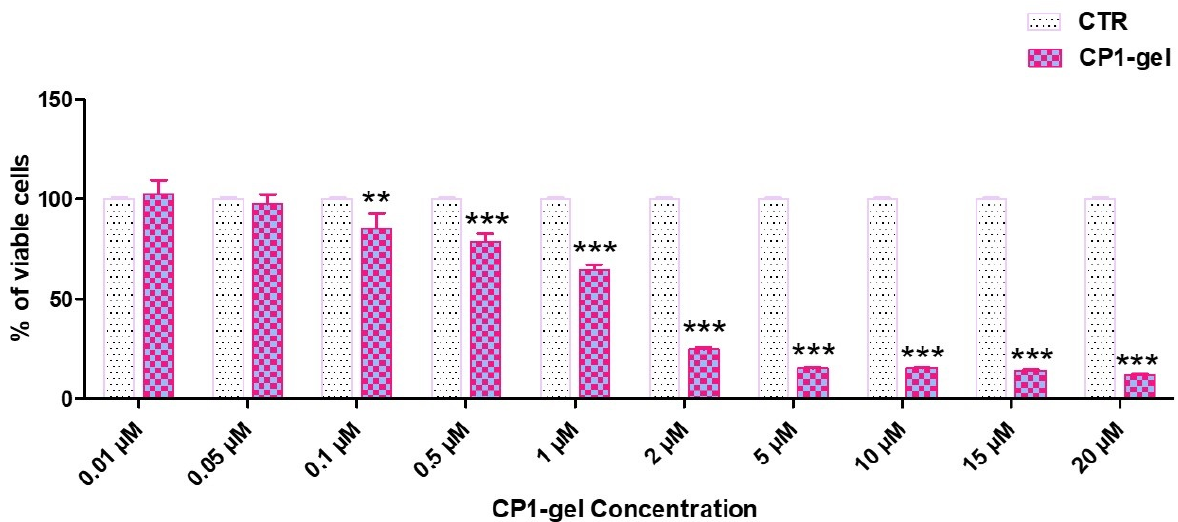
Figure 12. Results from dose-dependent cytotoxicity experiments carried out on MAIL-2 human cells at 24 h exposure to CP1-gel (CP1-gel concentration means the concentrations of CP1 in the gel samples used in the experiments). ** = p < 0.01; *** = p < 0.001 by two-way ANOVA statistical analyses.